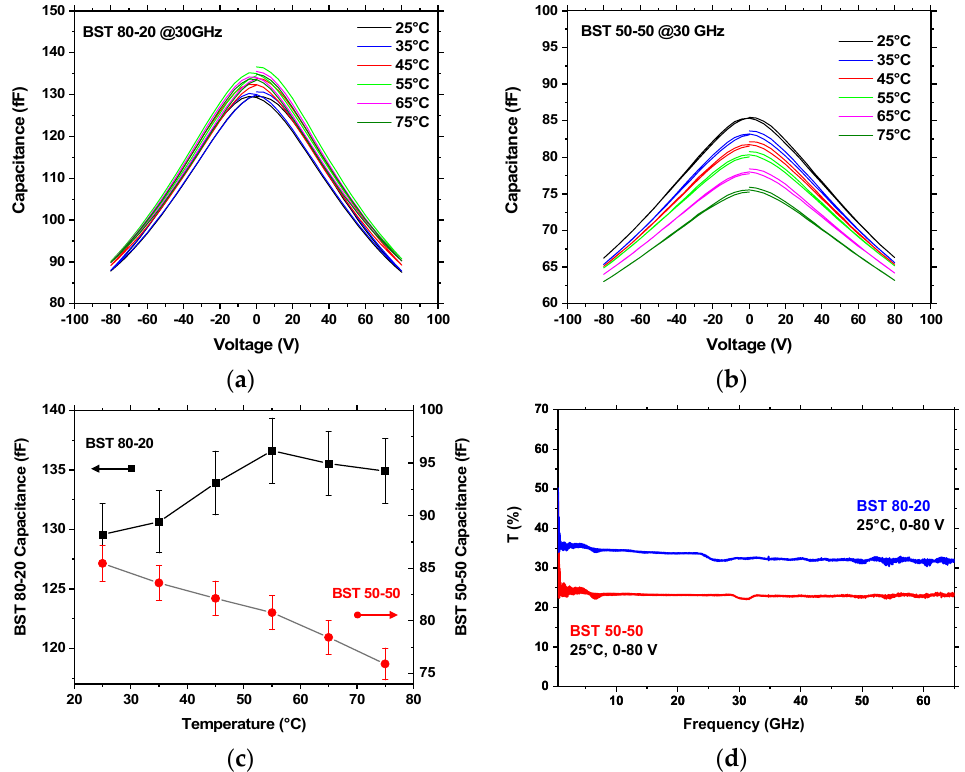
Figure 3. Capacitance variation as a function of the bias voltage at 30 GHz and at different temperatures for IDC devices integrating BST 80–20 ( a ) and BST 50–50 ( b ), evolution of the device capacitances at 30 GHz and 0 V bias with temperature (error bar amplitude at 2% of the measured value) ( c ), and room temperature frequency-dependent tunability T of both BST compositions at 133 kV/cm ( d ).